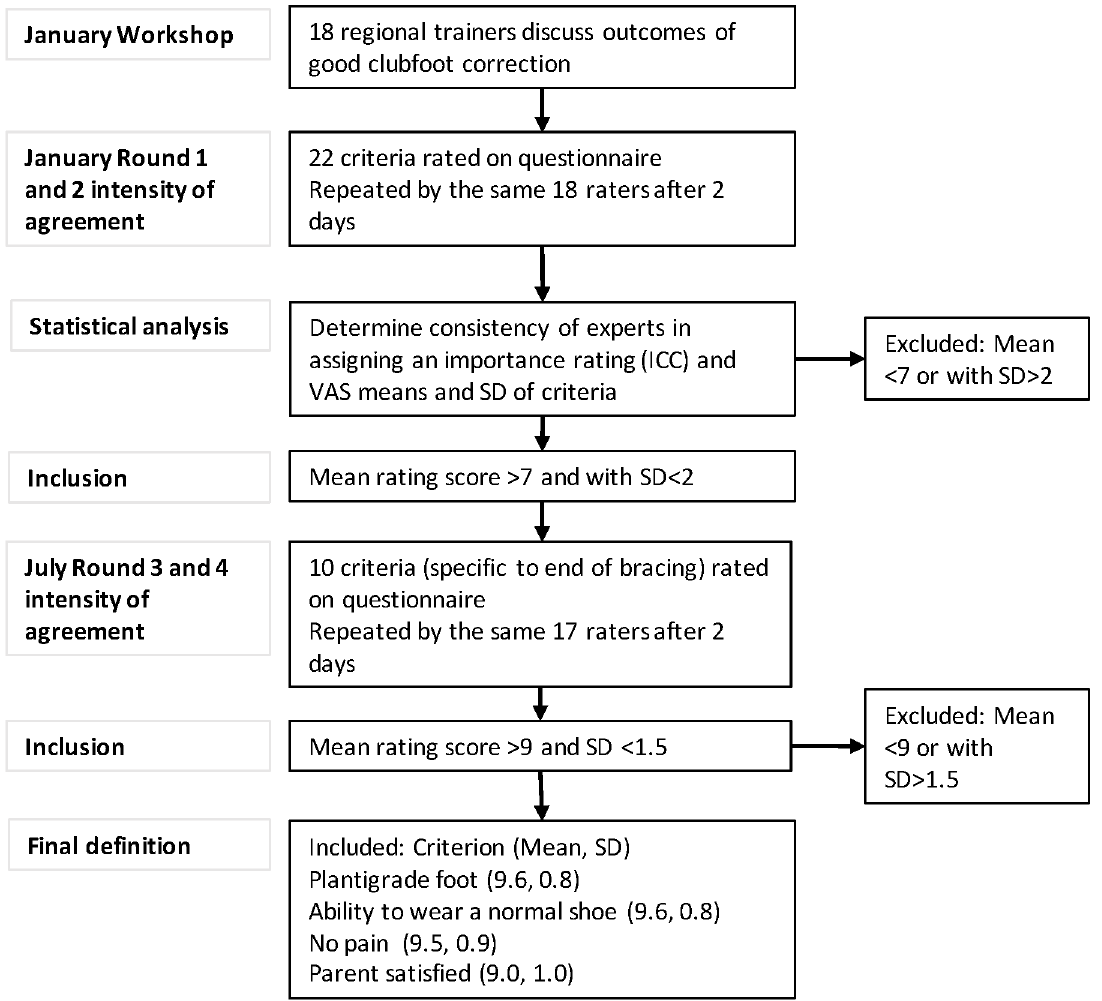
Fig 1. Flow chart of criteria selection. Definitionsof abbreviations:SD = standard deviation, ICC = intra-classcorrelation, VAS = visual analoguescale).